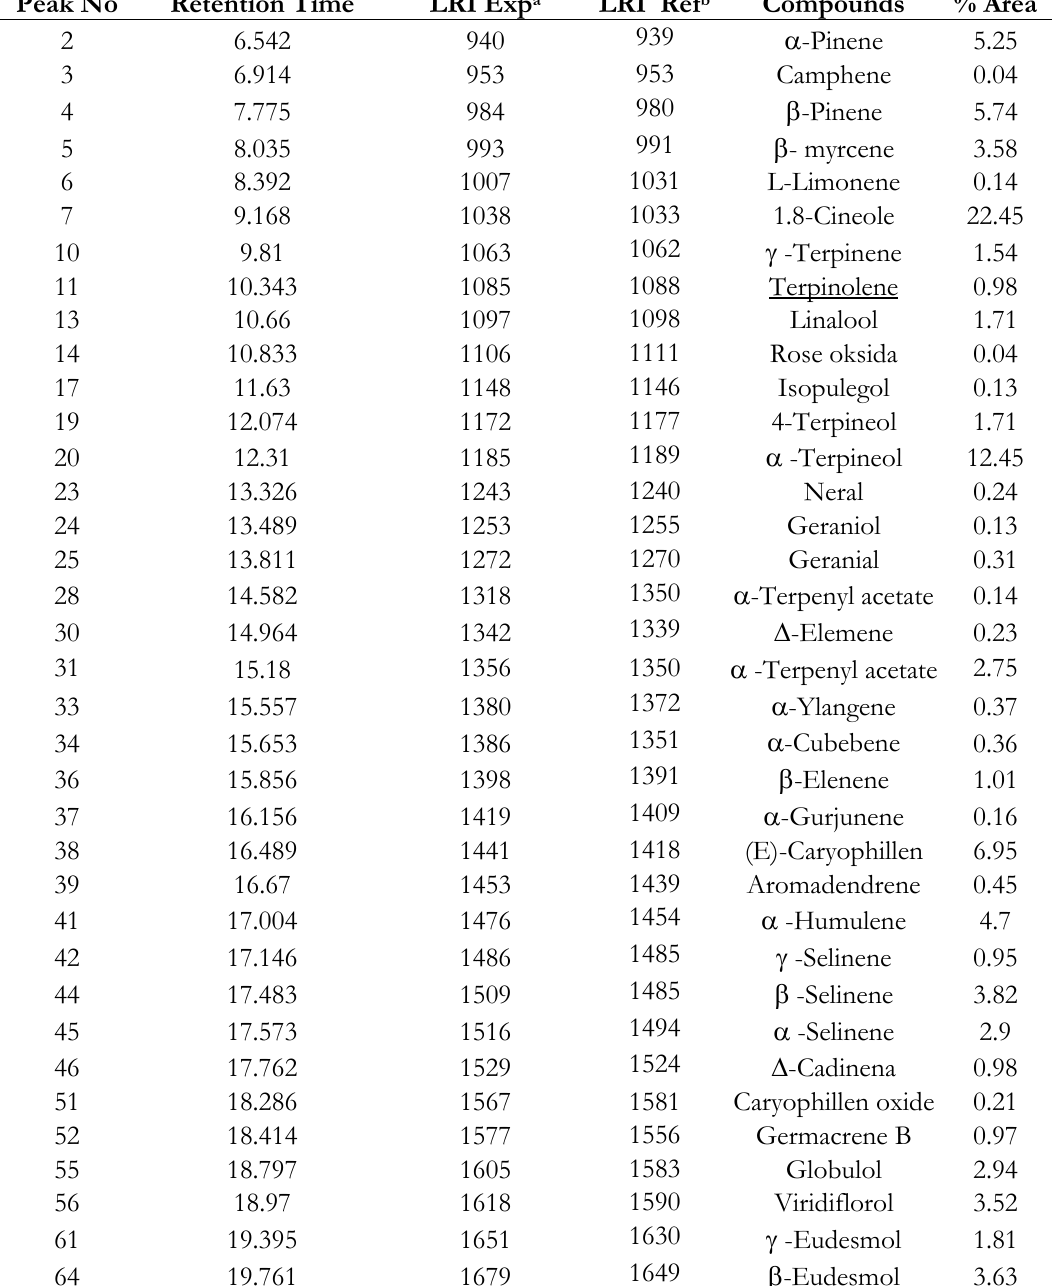
Table III. Chemical composition of the essential oil of Cajuput ( Meulaleuca lecadendron Linn.) Peak